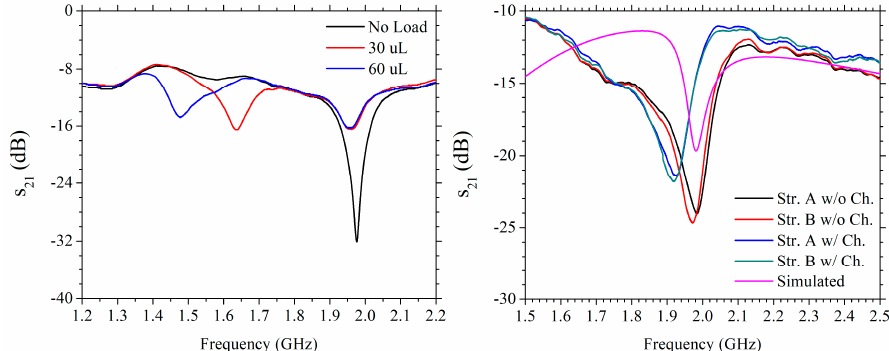
Figure 3. Resonant frequency of the SRR structure pair with and without channels fixed on them. ( left ) and shift in resonant frequency under dielectric loading in terms of DI water in different volumes ( right